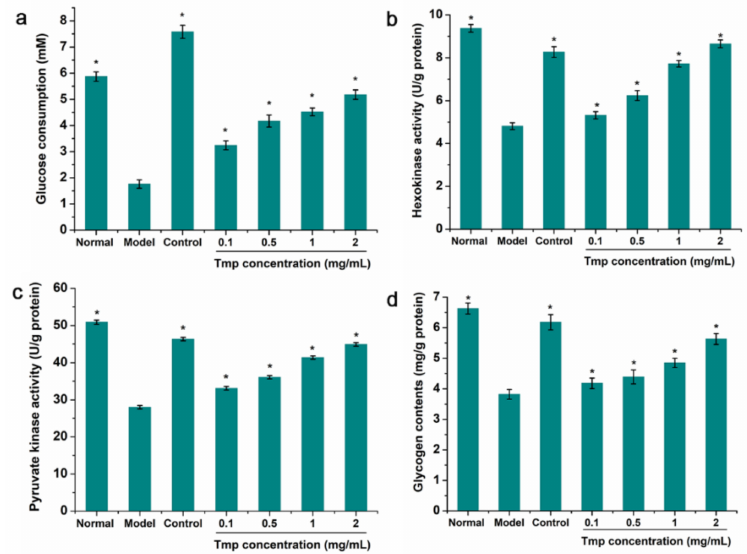
Figure 6. Effects of Tmp with various concentrations on glucose consumption ( a ), HK activity ( b ), PK activity ( c ) and glycogen content ( d ) in IR-HepG2 cells. Metformin (3.5 mg/mL) was used as the control group. * p < 0.05 vs. the model group. Values are presented as mean ± SD of triplicate